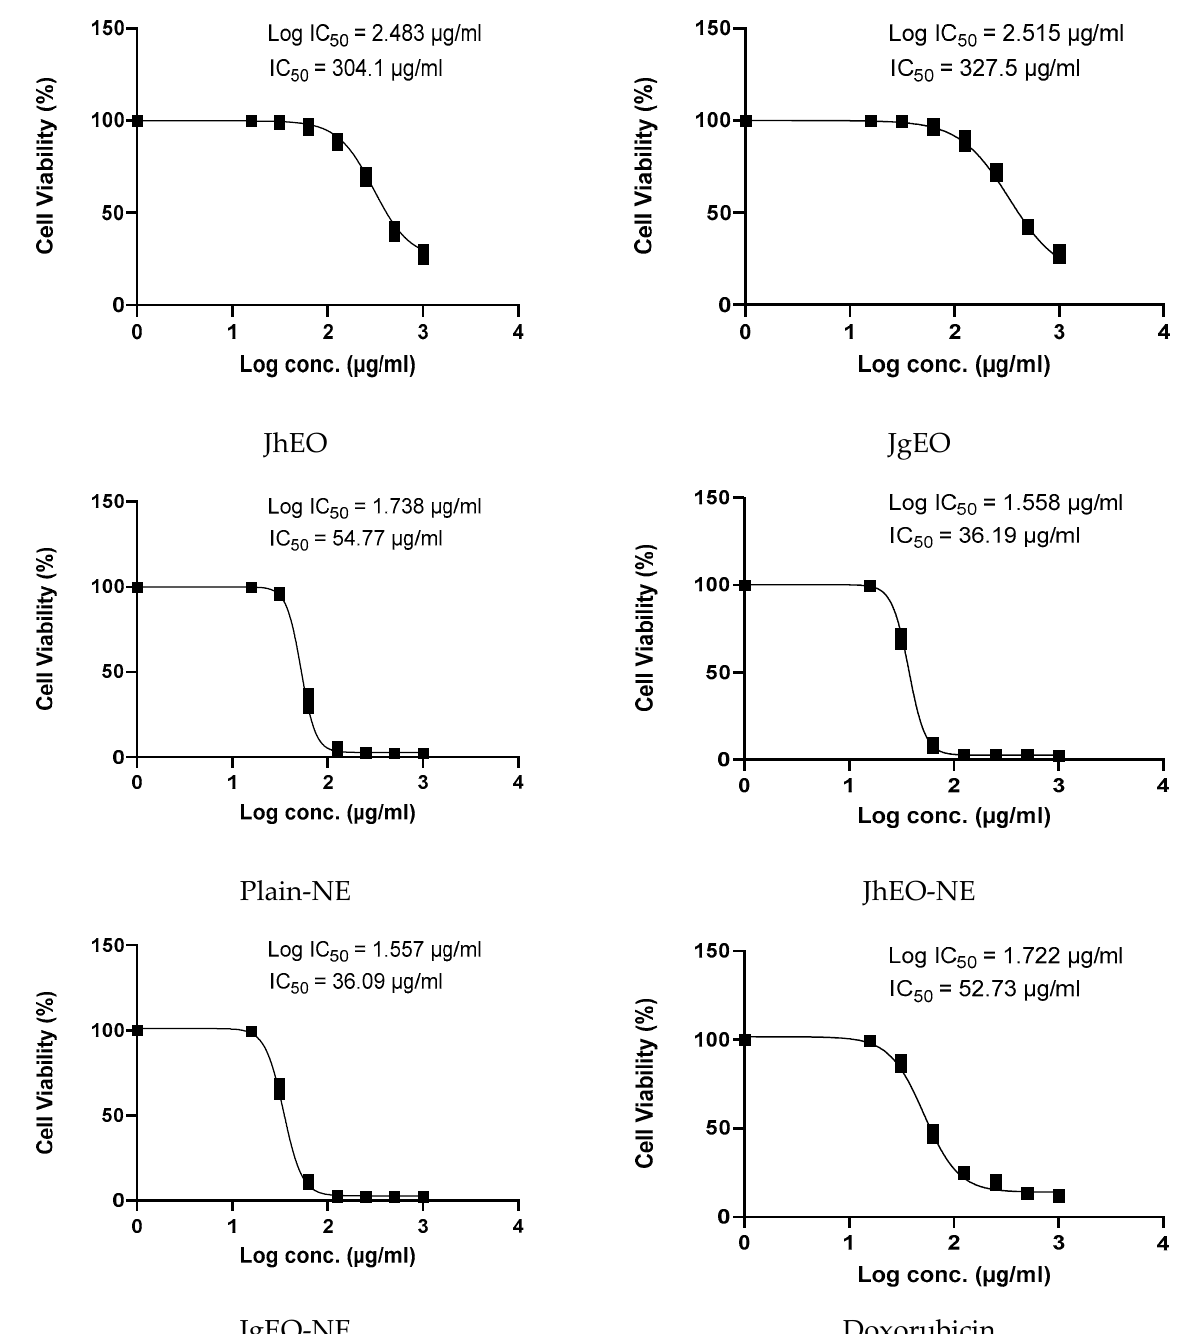
Figure 3. IC 50 of J. humile (JhEO) and J. grandiflorum (JgEO) pure essential oils, their nanoemulsion formulations (JhEO-NE) and (JgEO-NE), plain nanoemulsion formulation (Plain-NE) as well as standard doxorubicin against MCF-7 cell line.